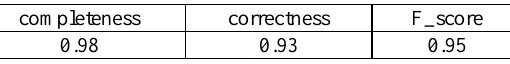
Table 15. Evaluation of guideline of case